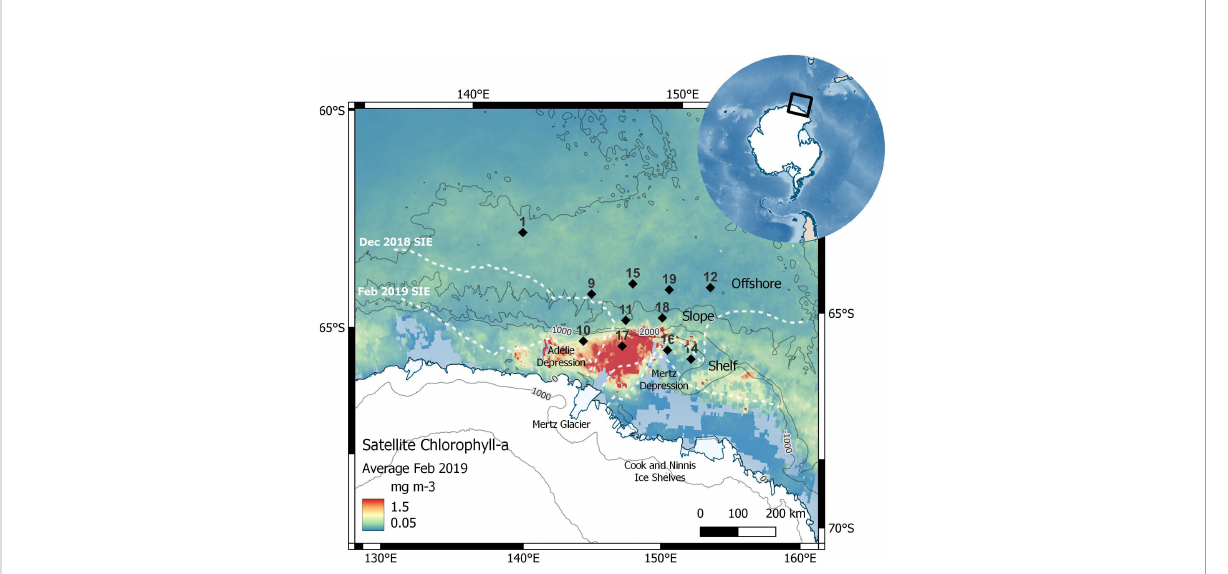
FIGURE 1 Survey sampling stations (black diamonds) within the Mertz Glacier Region. Background colour shows monthly average satellite chlorophyll- a (Chl- a ) concentration for February (NASA Giovanni MODIS-Aqua). Monthly average sea-ice extent (SIE, ≥ 15% sea-ice concentration) for December 2018 and February 2019 (white dashed lines, Meier et al., 2021) and bathymetric contours (light grey solid lines, IBSCO) are shown. Stations were divided into three groups (Offshore, Slope, and Shelf) based on their proximity to continental shelf. Figure developed using the Norwegian Polar Institute ’ s Quantarctica package (Matsuoka et al.,